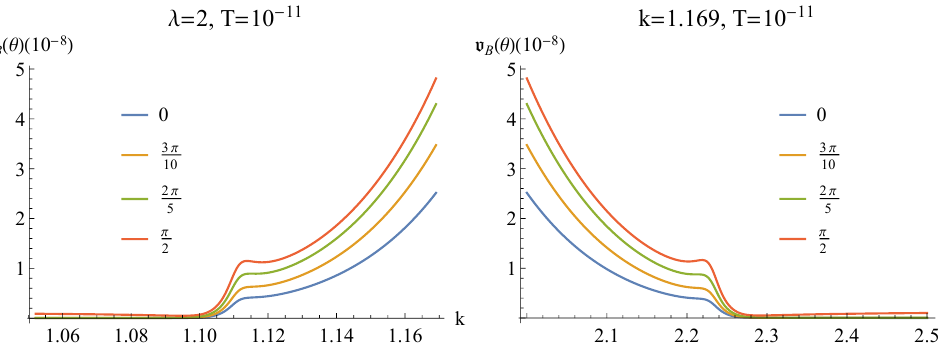
Figure 5 . v B ( (cid:18) ) v.s. (cid:18) at (cid:21) = 2 ; T = 10 (cid:0) 11 with k speci(cid:12)ed by the plot legend.